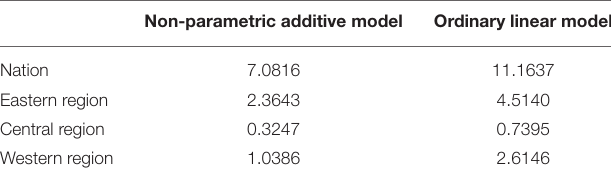
TABLE 6 | Residual sum of squares between the non-parametric additive model and the ordinary linear model.